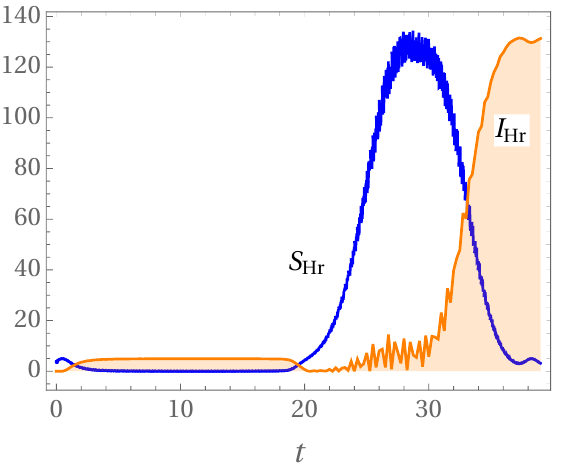
Figure 4. Hawking radiation’s Wehrl entropy and information evolution over time, with m Pl = ¯ h = ω x = x 0 = 1; p 0 = − 1. The back reaction coupling parameter is µ = 1.01, where ω y = ω x × 10 5/2 and m y = m Pl × 10 − 5